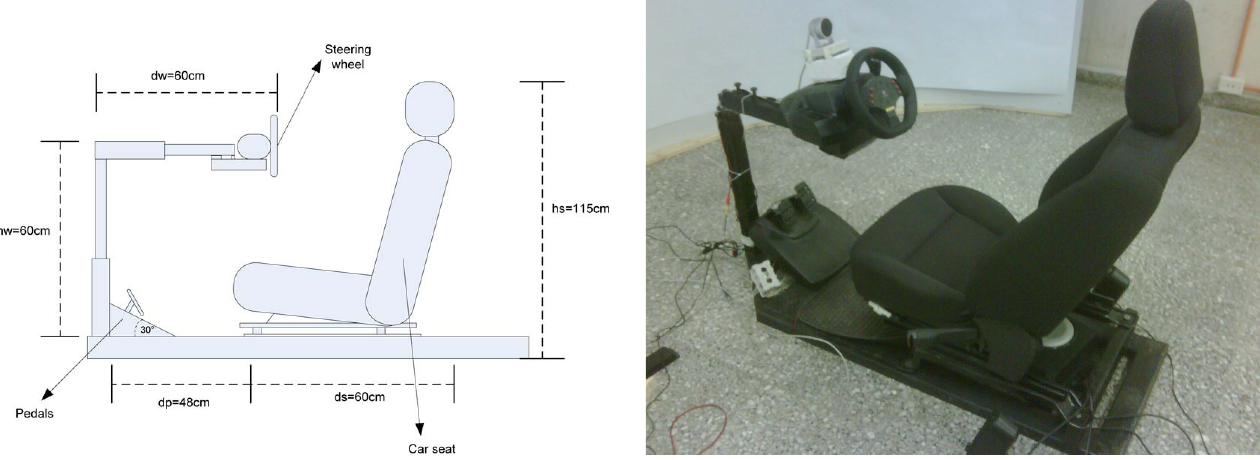
Figure 11. Dimensions and view of the driving seat and steering wheel